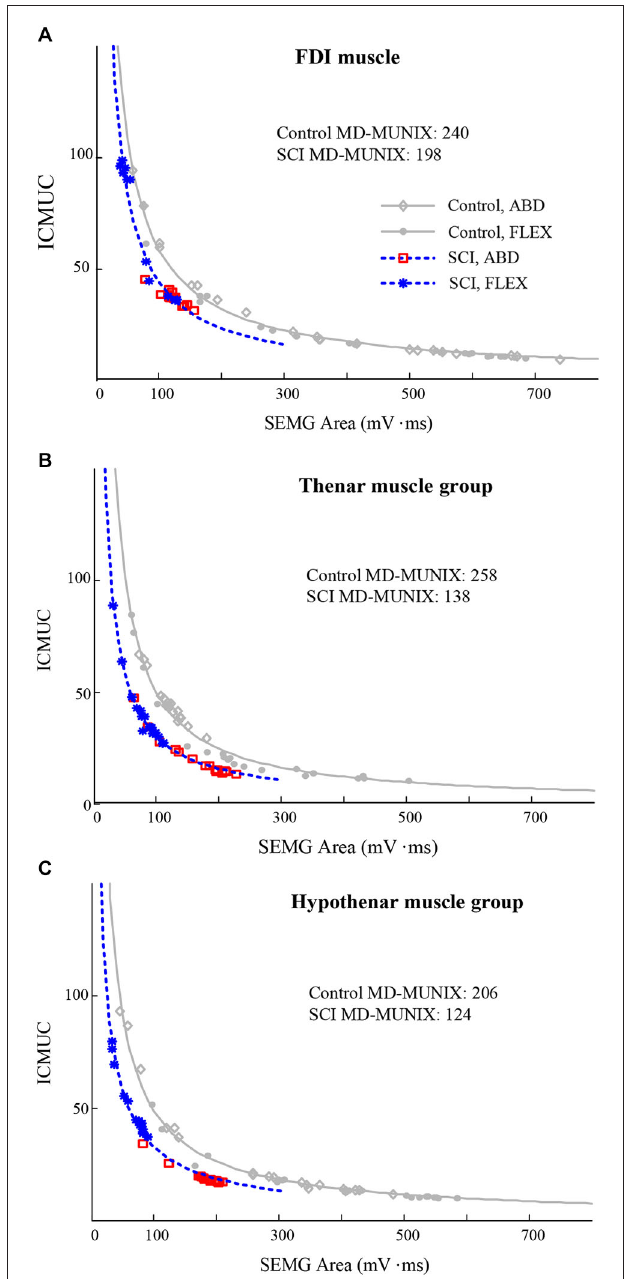
FIGURE 2 | Examples of MD-MUNIX calculation in representative SCI and healthy control subjects . The MD-MUNIX was derived using the CMAP and the voluntary surface EMG in both abduction (ABD) and flexion (FLEX) modes for the curve fitting. (A) the FDI muscle; (B) the thenar muscles; (C) the hypothenar muscles.